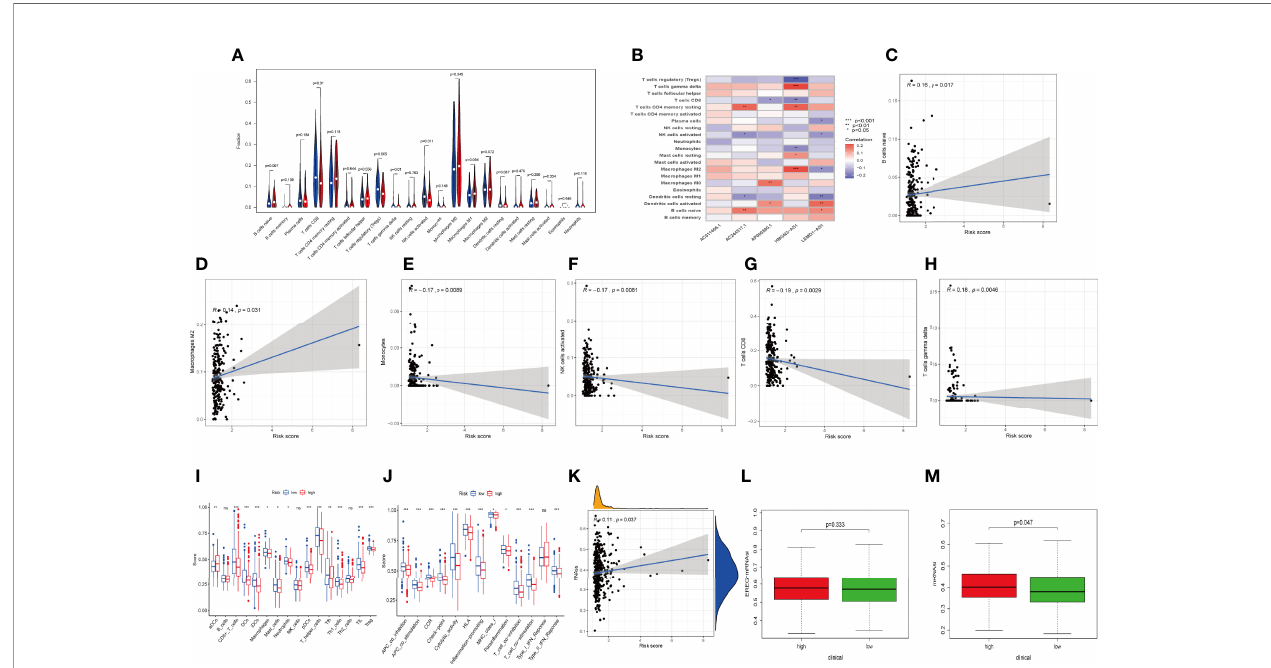
FIGURE 8 | Relationships between IRLPS and different aspects in the immune microenvironment, including in fi ltration abundances and activation status of immune cells and cell stemness. (A) Violin plot depicts 21 immune cell types that is differently distributed in high and low risk IRLPS risk score groups. (B) The correlation of IRLs expression and in fi ltration abundance of immune cells, visualized by heatmap. (C – H) The correlation of 6 immune cell types with the 5 IRLs in our risk signature. (I, J) ssGSEA reveals signi fi cant difference in (I) immune cell abundance and (J) activation of immune processes between the groups. (K) Correlation analysis implies signi fi cant relationship in cancer cell stemness represented by methylation of RNA (RNAss) with risk score. (L) No signi fi cant difference in epiregulin mRNA stemlike indices (EREG mRNAsi) between the groups. (M) The mRNA based stemlike indices (mRNAsi) is signi fi cantly different in the groups. *P < 0.05, **P < 0.01 ***P < 0.001, ns indicates no statistical